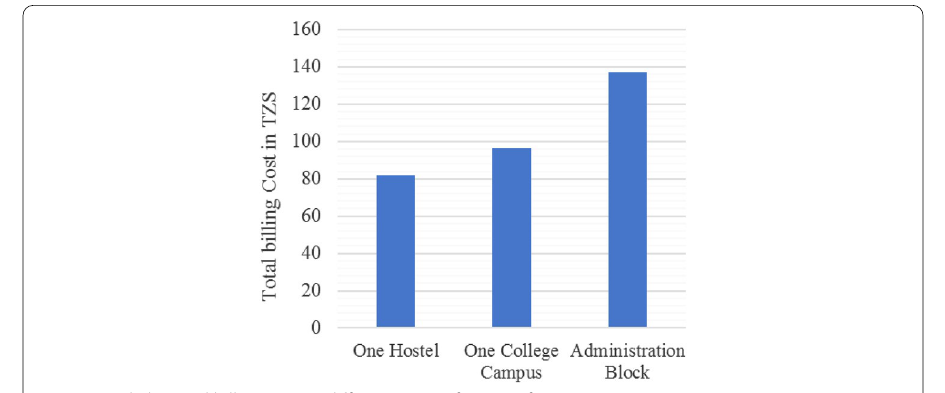
Fig. 6 Total electrical billing cost to different areas of CoICT of UDSM